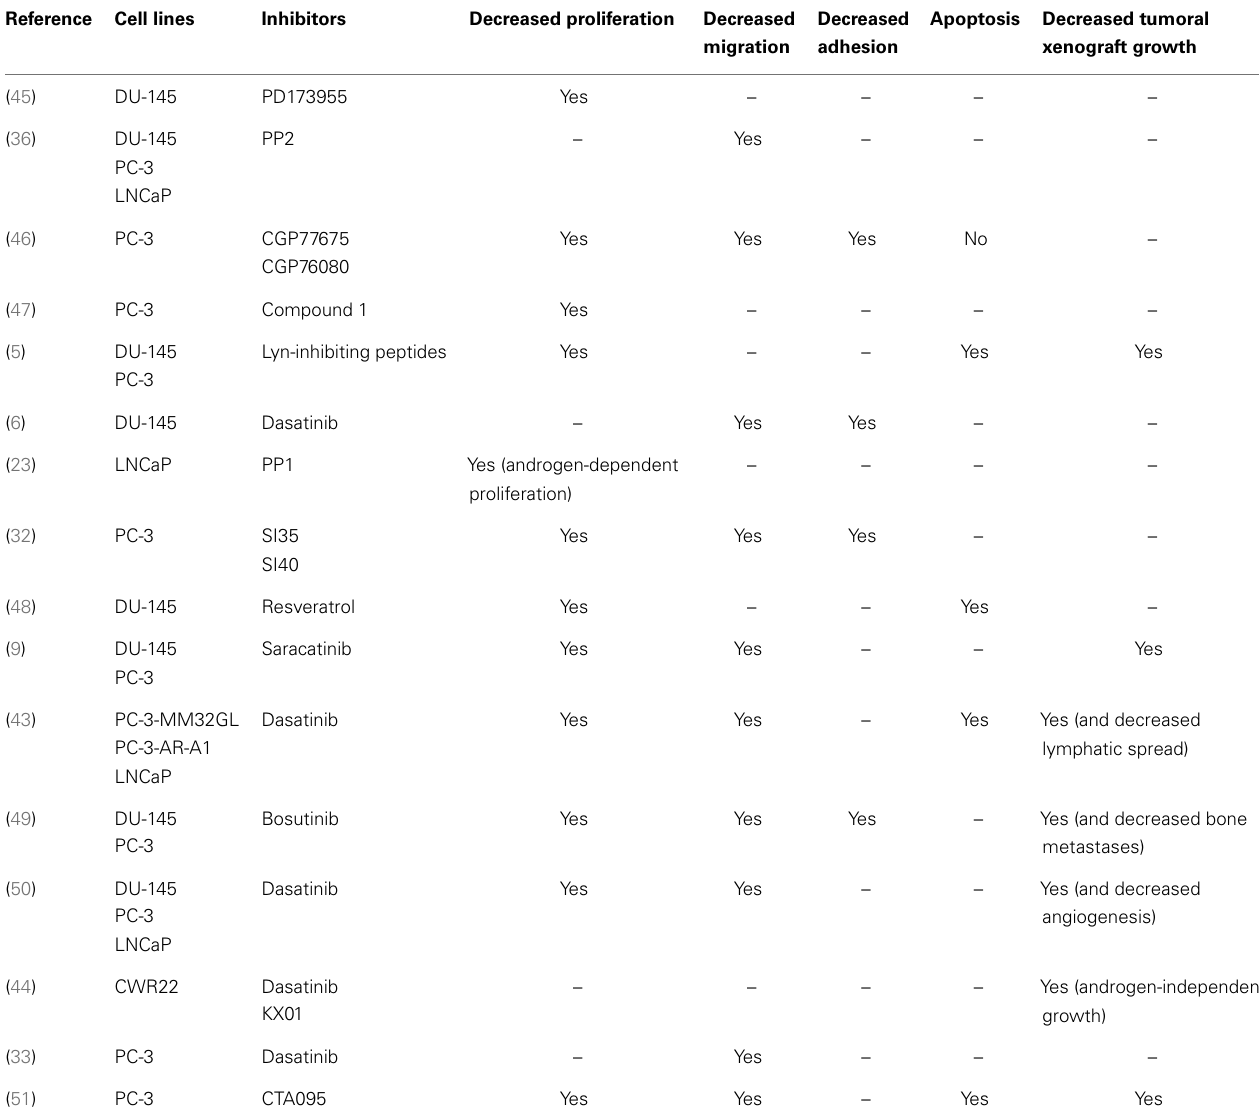
Table 2 | Representative studies that evaluated the biological effects of Src inhibitors on basic cellular events associated with prostate cancer progression